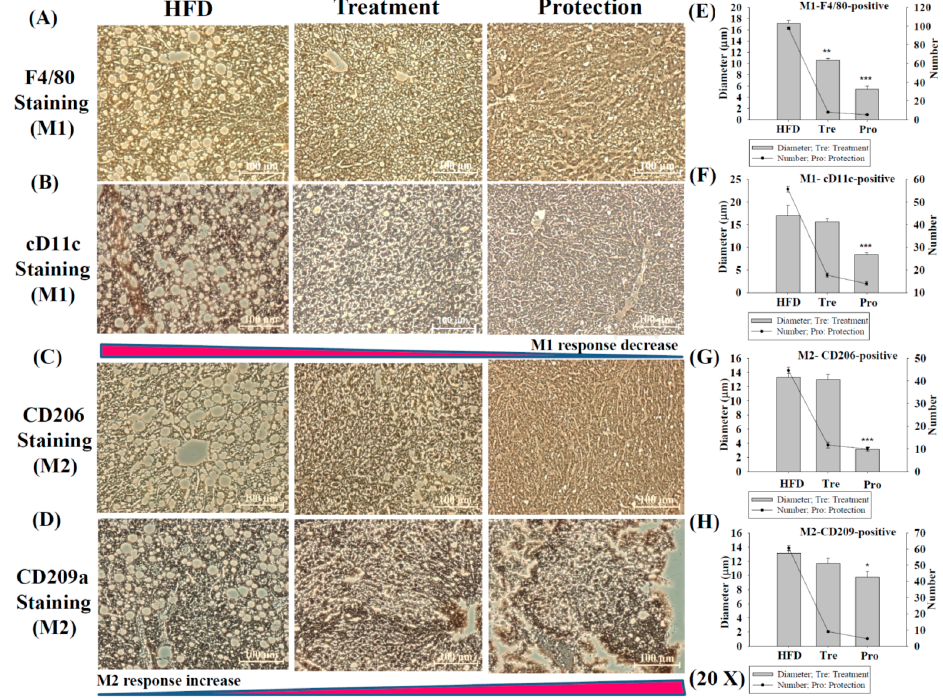
Figure 4. IHC staining of infiltrated M1/M2 macrophages and accumulated oil globules treated/protected with KMUP-1. KMUP-1 (2.5 mg/kg/day) administration for 6 weeks/14 weeks modulates the balance of infiltrated macrophages 1 (M1; A , B ) and macrophages 2 (M2; C , D ). KMUP-1 significantly affected the M1 (CD11c, dark brown)/M2 (CD209a, dark brown) macrophages polarization, but little affected the balance of M1 (F4/80, brown) and M2 (CD206, brown), in treatment and protection groups. All the accompanied oil globules were reduced by KMUP-1. The number and diameter changes of oil globules are in the average from M1/M2-positive cells ( E – H ). Data are means ± S.E. of three independent experiments. * p < 0.05; ** p < 0.01; *** p < 0.001 versus HFD group. Scale bar: 100 µm.